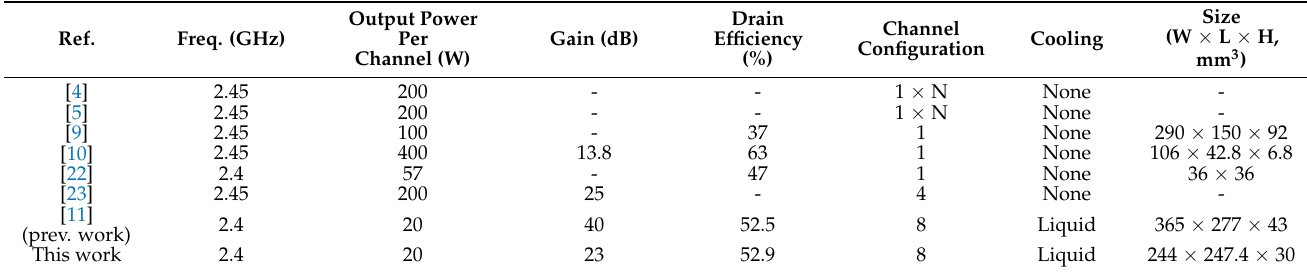
Table 3. Comparison with 2.4 GHz ISM band RF sources for plasma generator applications.